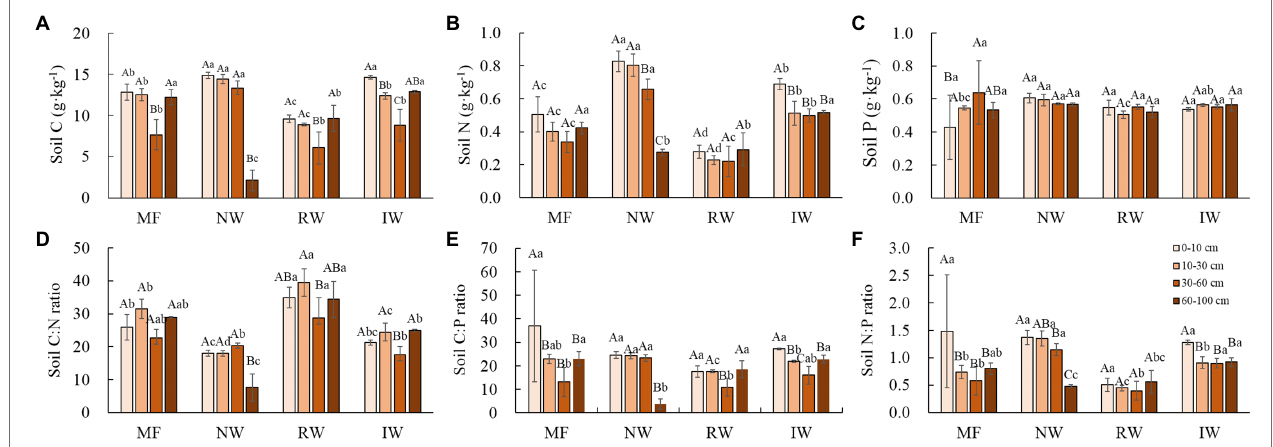
FIGURE 3 | Distributions of the soil C content (A) , soil N content (B) , soil P contents (C) , soil C:N ratio (D) , soil C:P ratio (E) , and soil N:P ratio ( F ; means ± SD, n = 3) under different land-use types in Hangzhou Bay. Different capital letters in the same land-use type indicate a significant difference among soil depths at p < 0.05, and different lower-case letters in the same soil depth indicate a significant difference among land-use types at p <